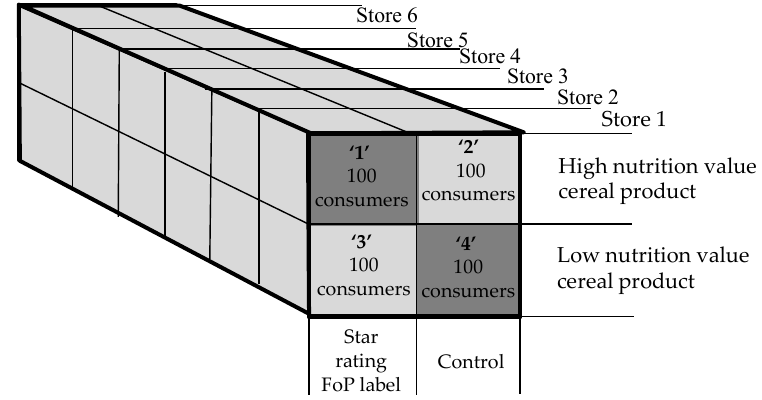
Figure 4. Experimental design.